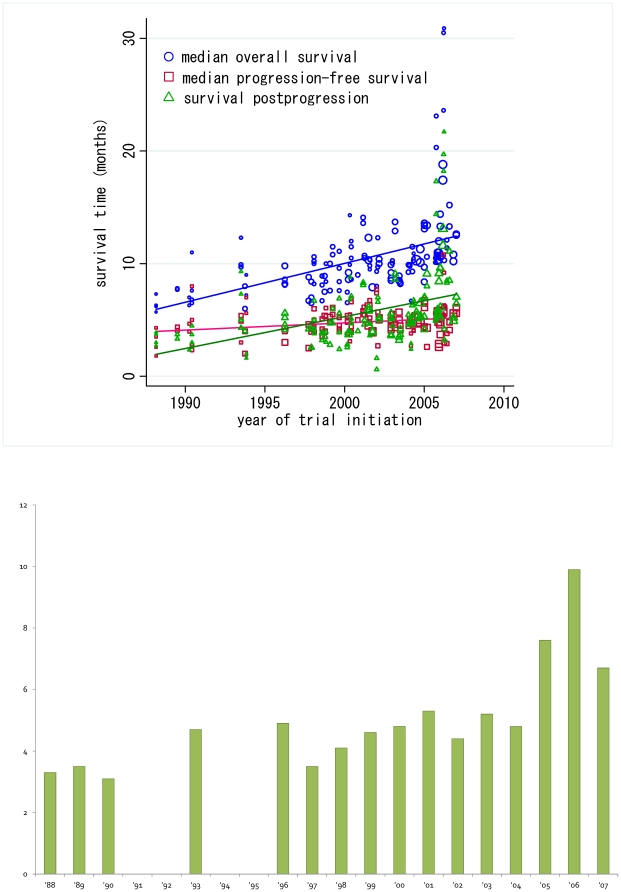
Time trends in survival data.A. Trend in survival times in advanced NSCLC patients enrolled into phase III trials. Median survival time (0.3751-month [11.253-day] increase per year; p<0.001; blue), median progression-free survival time (0.0621-month [1.863-day] increase per year; p = 0.006; pink), survival post-progression (0.3138-month [9.414-day] increase per year; p<0.001; green). All analyses were weighted by trial size. Y-axis indicates survival time of each endpoint (months). B. Absolute mean SPP value per year. X-axis and Y-axis indicate year of trial initiation and mean SPP value (months) in each year, respectively.